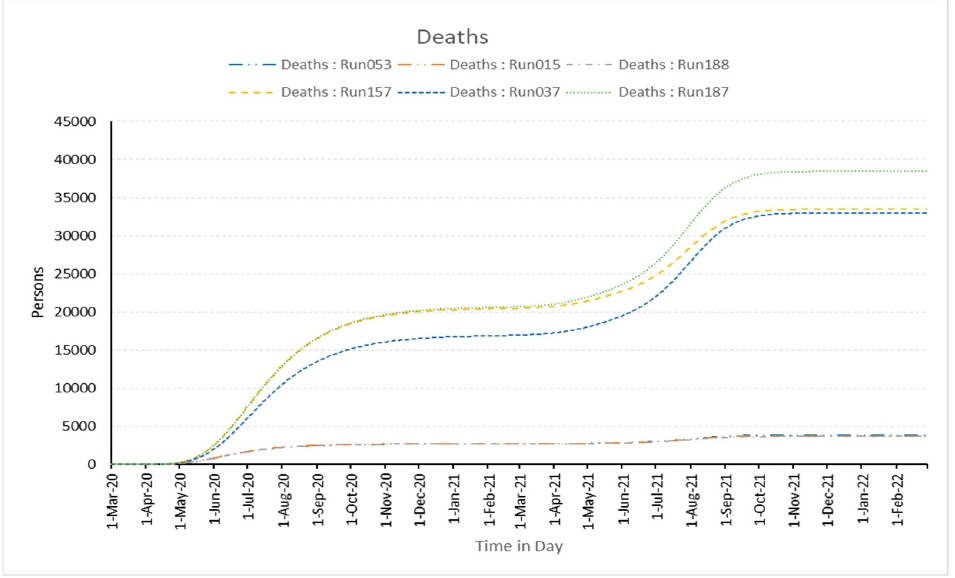
Figure 7. Number of deaths in simulation runs best-fitted runs (Run053, Run015, and Run188) and worst-fitted runs (Run037, Run157, and Run187). worst-fitted runs (Run037, Run157, and